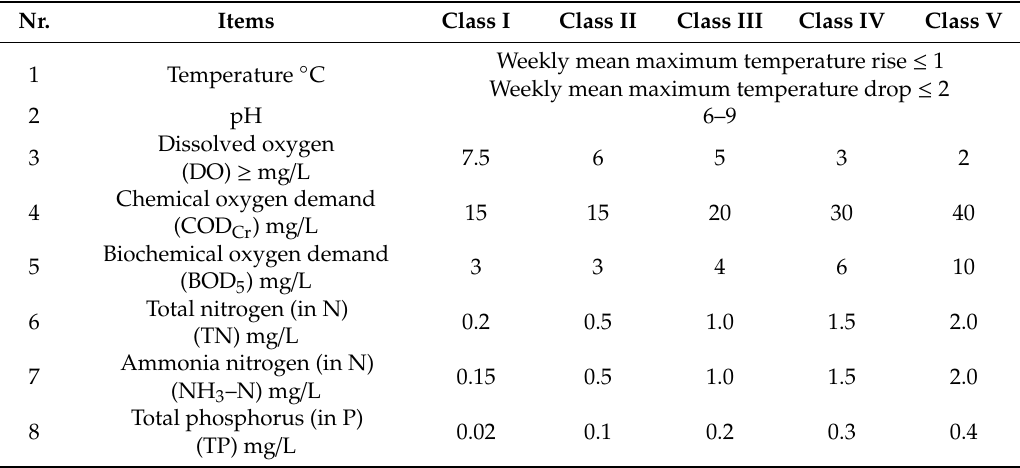
Table 2. Water quality standards of surface water.